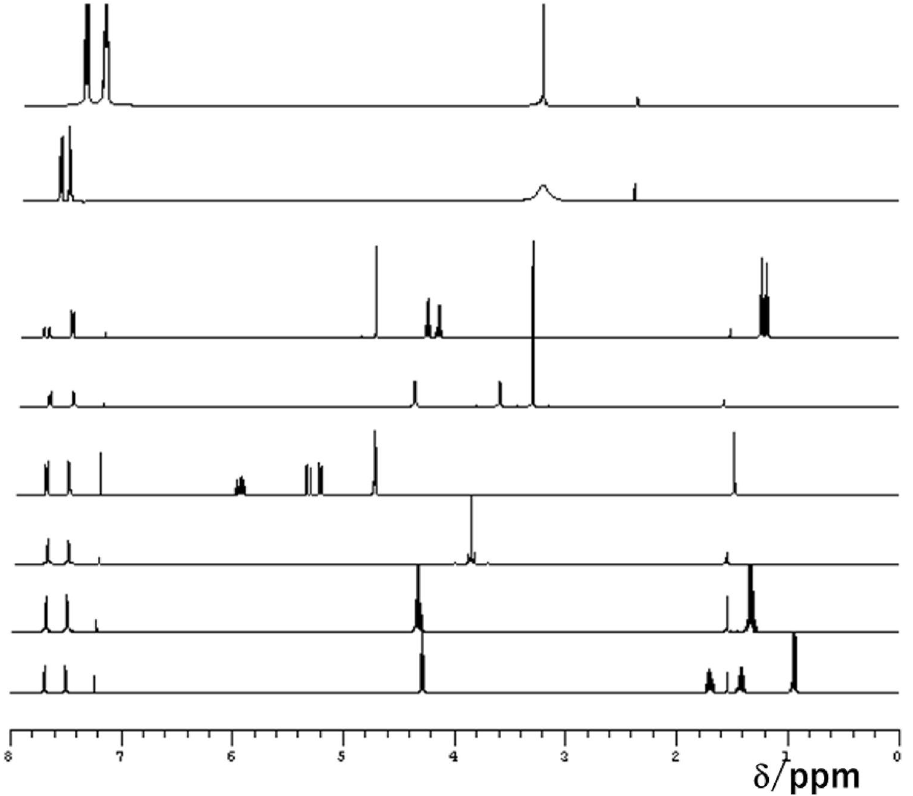
Figure 3. 1 H NMR spectra of (from top to bottom): the white precipitate, phthalic acid, ethyl phthalyl ethyl glycolate, bis(2-methoxyethyl) phthalate, diallyl phthalate, dimethyl phthalate, diethyl phthalate, and dibutyl phthalate in CDCl